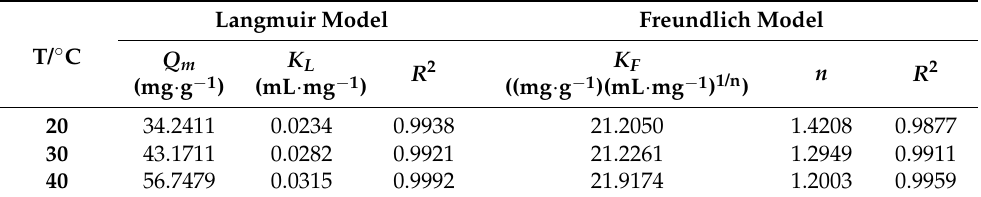
Table 3. Langmuir and Freundlich isotherm parameters for adsorption kinetics of TFC on D-101